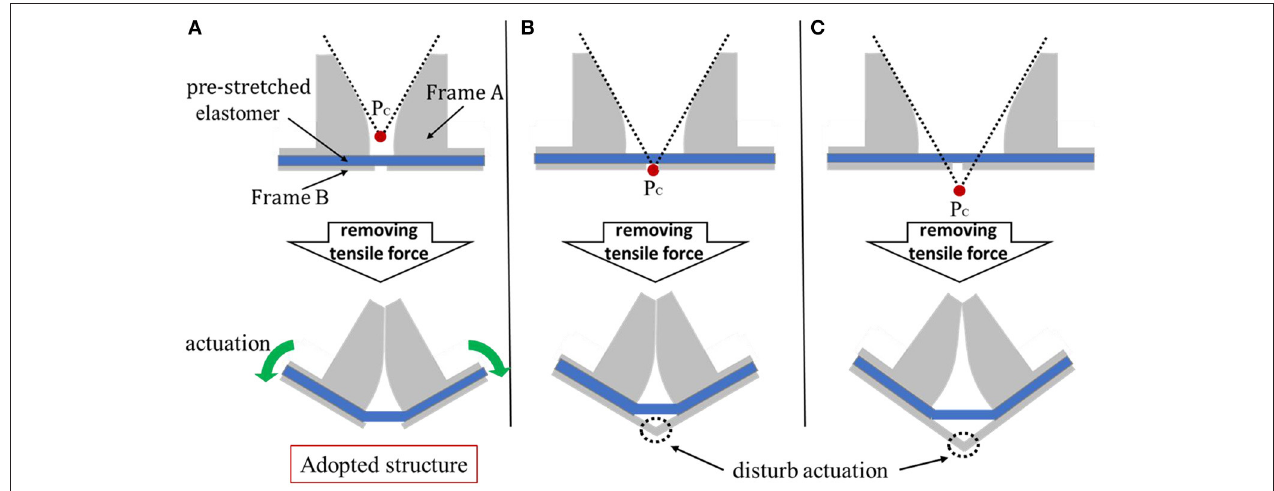
FIGURE 7 | Three examples of relationship between gaps and self-folding between frames A. In this research, in order to optimize the operation of the actuator, we designed the distance between frames A to be 2mm and that of B to be 1mm as shown in (A) . (A) The case where point Pc is above the plane where Frame B exists. This structure was adopted in this research. (B) The case where the point Pc is on the plane where Frame B exists. In this state, the actuator does not operate when voltage is applied. (C) The case where point Pc is below the plane where Frame B exists. As in case B, the actuator does not operate.